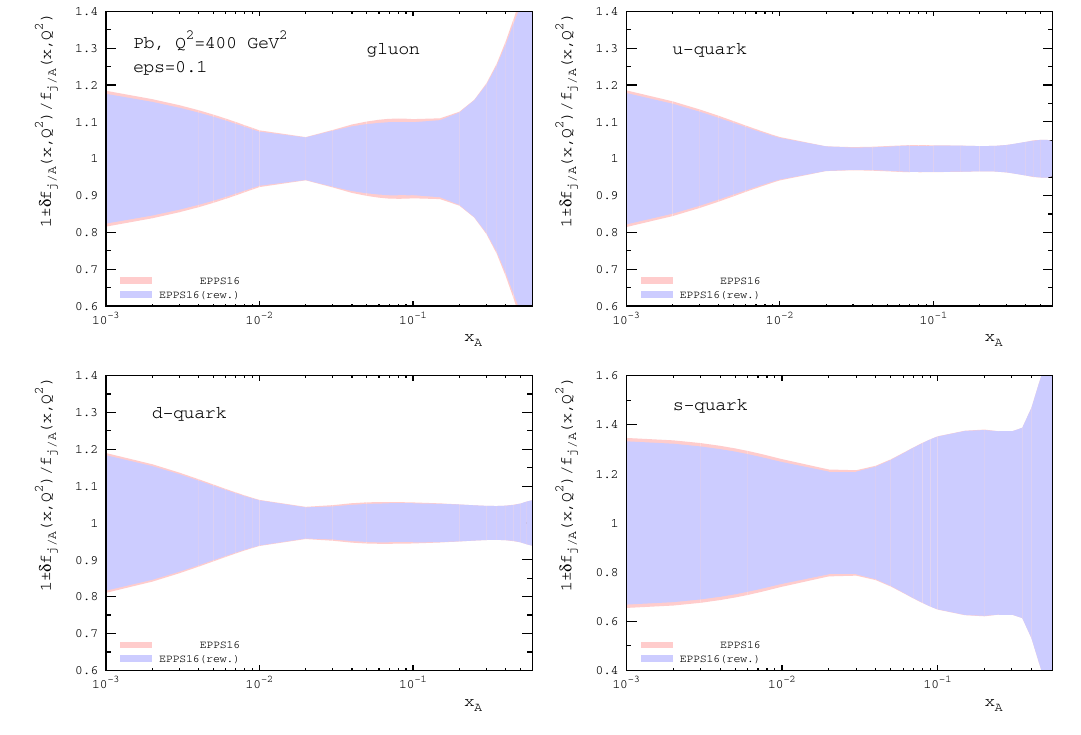
Fig. 11 The same as Fig. 10, but with (cid:6) = 0 .